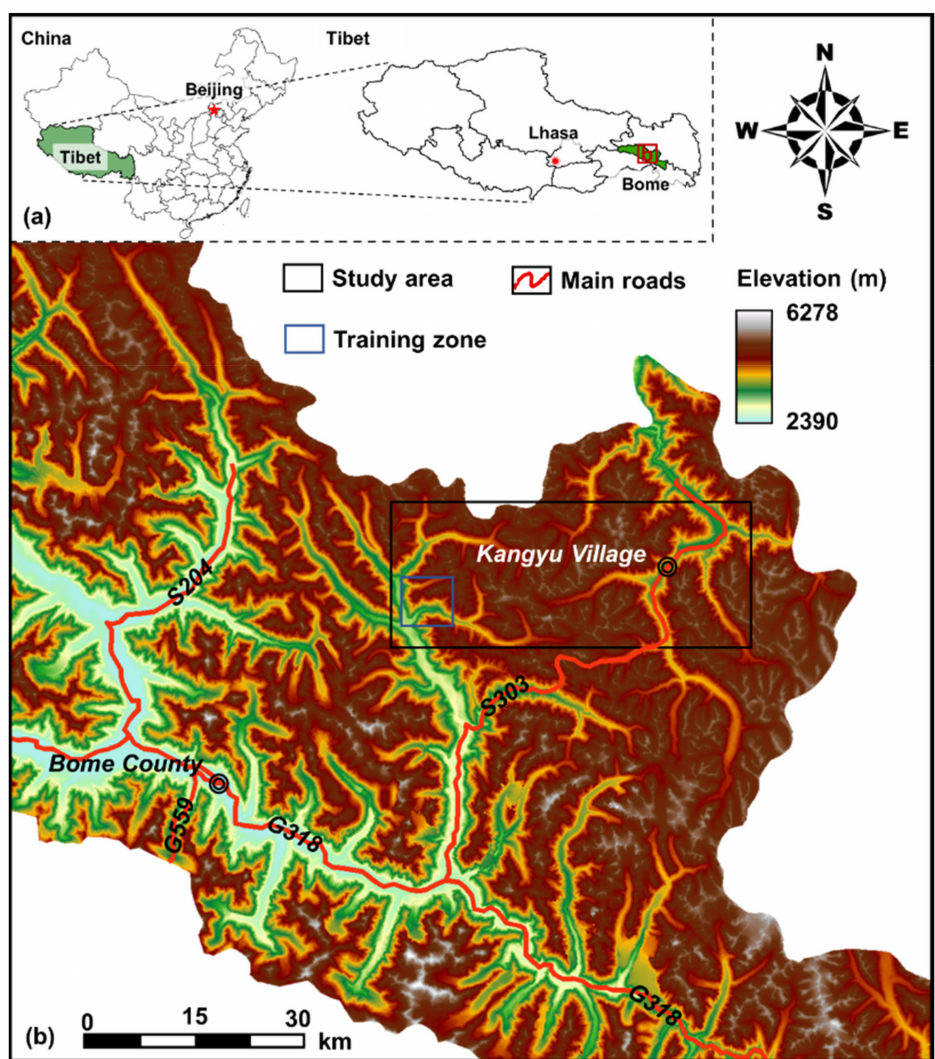
Figure 1. Locations of ( a ) Bome County and ( b ) the study area on a digital elevation map. (Source of the digital elevation model: National Aeronautics and Space Administration Shuttle Radar Topogra- phy Mission Global 1 arc second